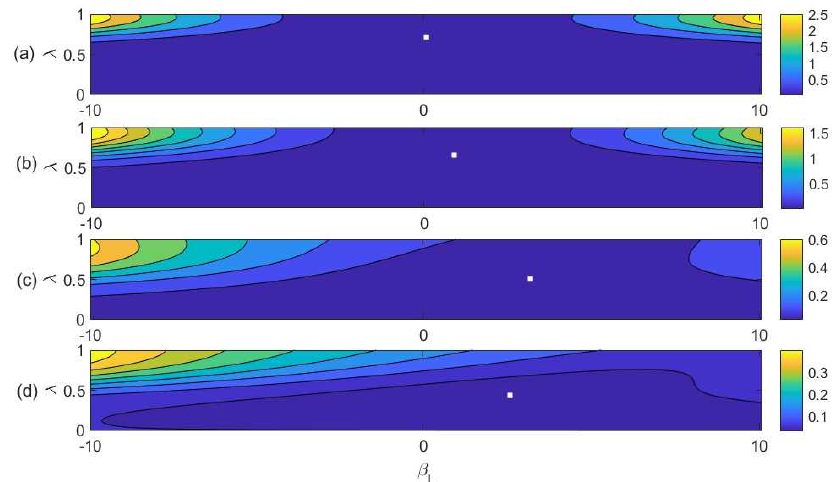
Figure 6. Heat-map plots of the mean square SNR error F ( x ) as a function of λ vs. β L after fixing the β T , σ T and σ L at the extracted optimal values for azimuth ( a ) 0 ◦ , ( b ) 10 ◦ , ( c ) 20 ◦ and ( d ) 30 ◦ . White dots are the optimal λ and β L values extracted from the